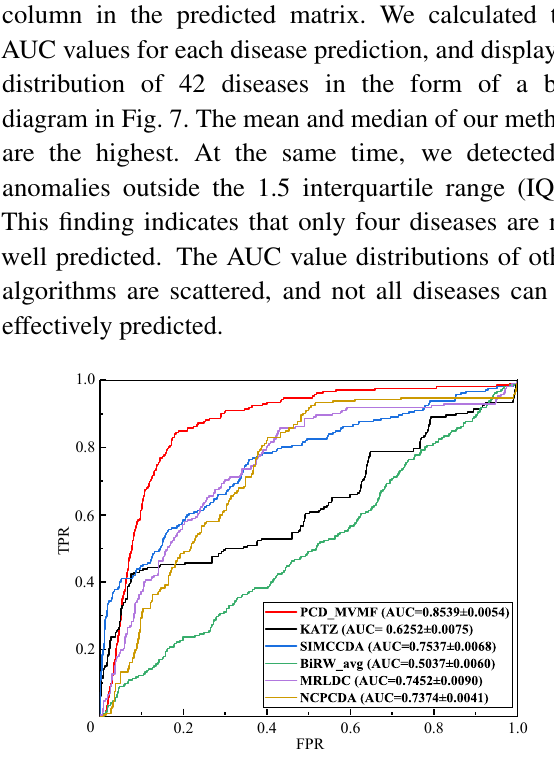
Fig. 3 ROC curves of PCD MVFM and other computational methods based on five-fold